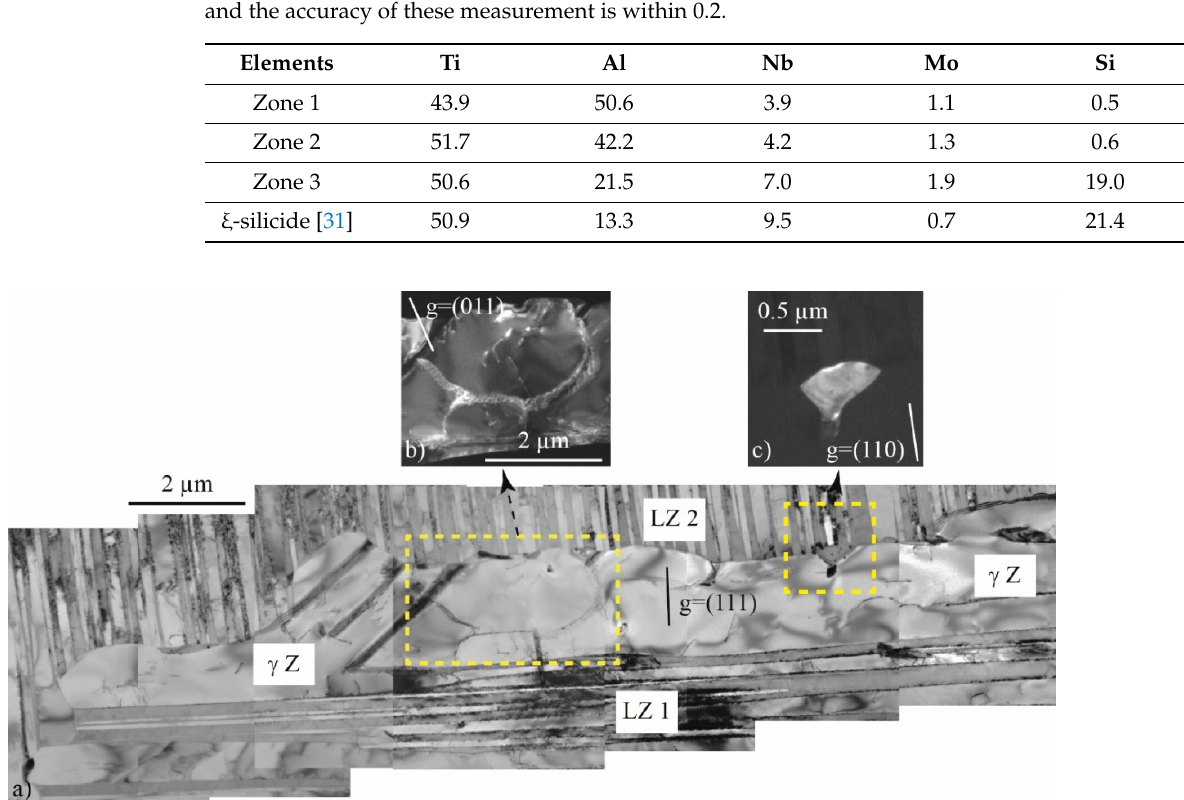
Table 4. Quantitative elemental analysis of the TNM + alloy densified at 1325 ◦ C by EDS-TEM at the local scale of three zones which are surrounded in colour in Figure 2b. The values are given in at.% and the accuracy of these measurement is within 0.2.